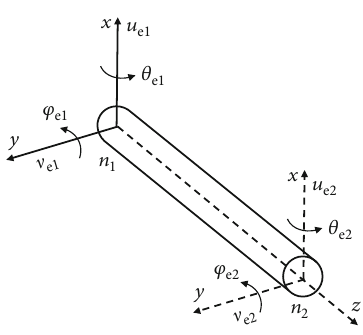
Figure 3: Schematic diagram of beam